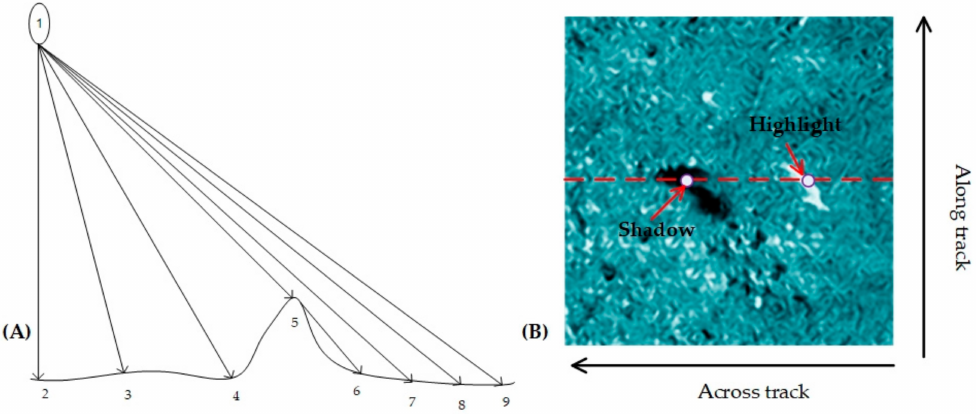
Figure 1. ( A ) A Ping measurement. ( B ) Highlighted and shadowed areas in the side scan sonar (SSS) image of a floating fish